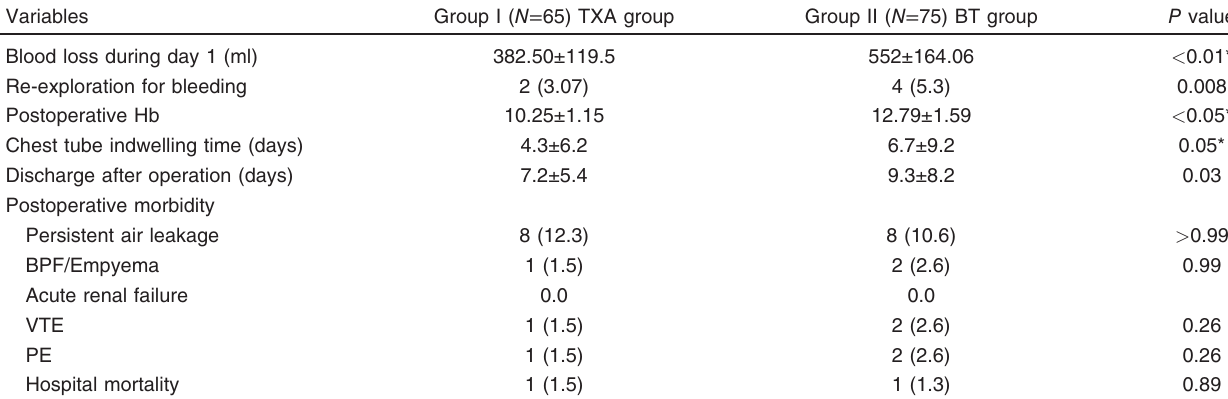
Table 3 Postoperative characteristics of patients in both groups (total number = 140 patients: group I = 65 and group II = 75)